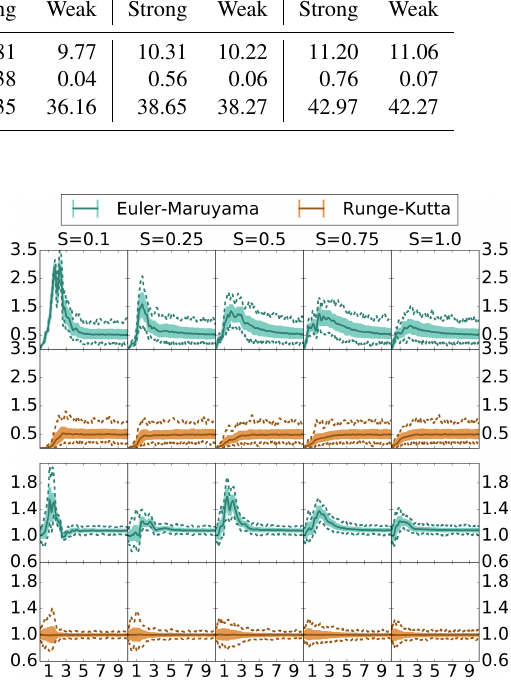
Figure 4. Ensemble forecast statistics deviation over time – coarse discretization. Euler–Maruyama and Runge–Kutta discretized with time step (cid:49) = 10 − 2 . Top: RMSD. Bottom: ratio of spread. Median – solid. Inner 80% – shaded. Min/max –